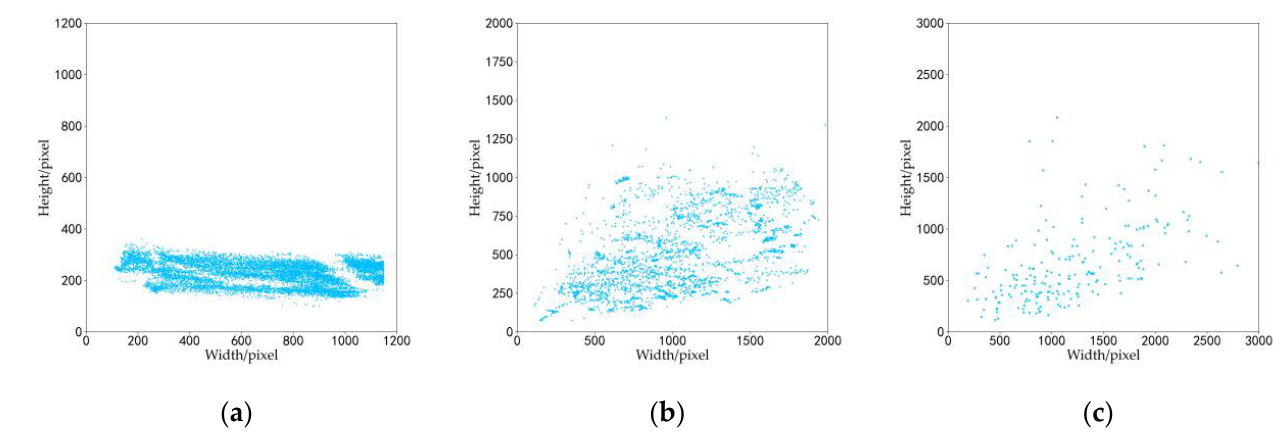
Figure 5. Target size scatter plot for the ( a ) simulation dataset, ( b ) real dataset, and ( c ) test dataset.